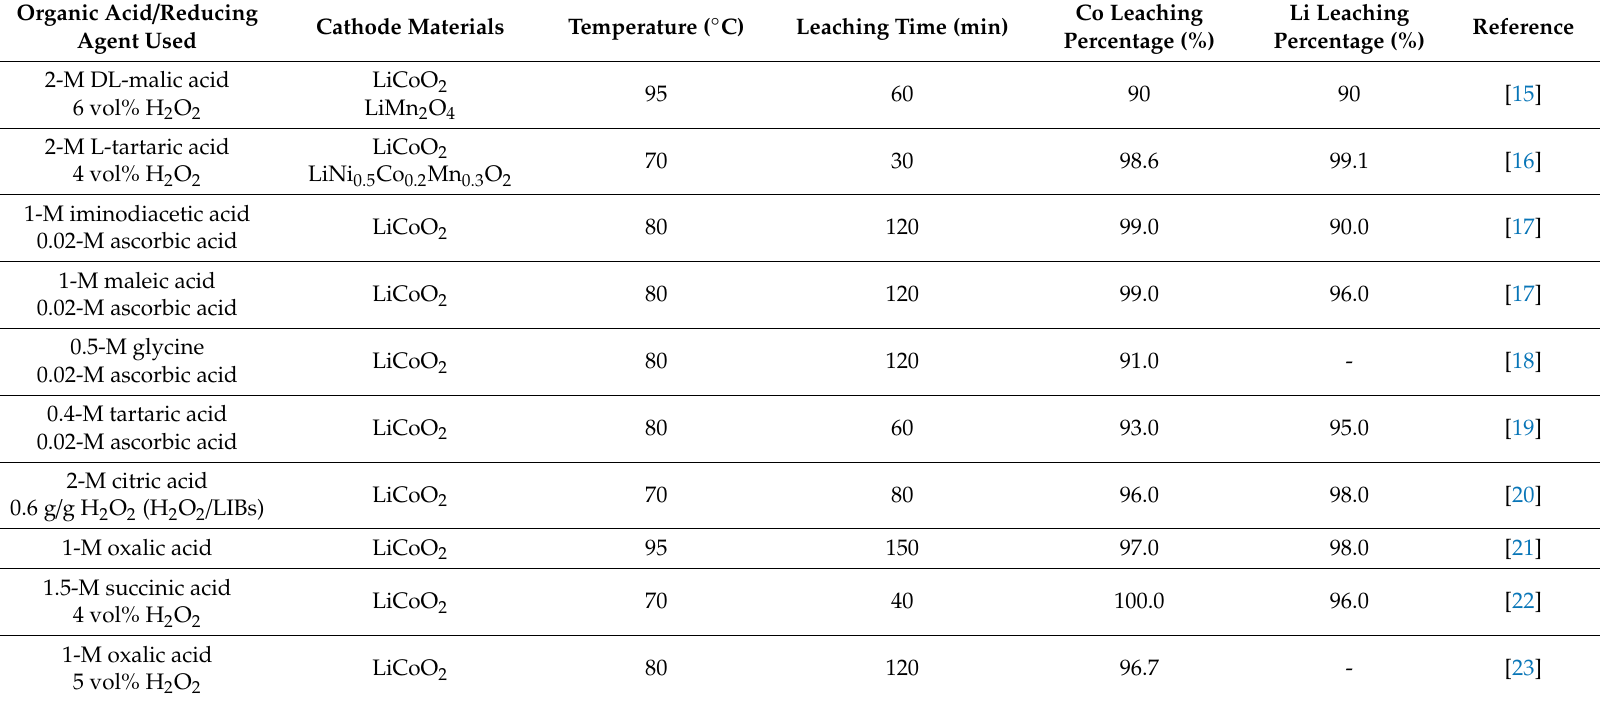
Table 1. Recent research for cathodic metals leaching by organic